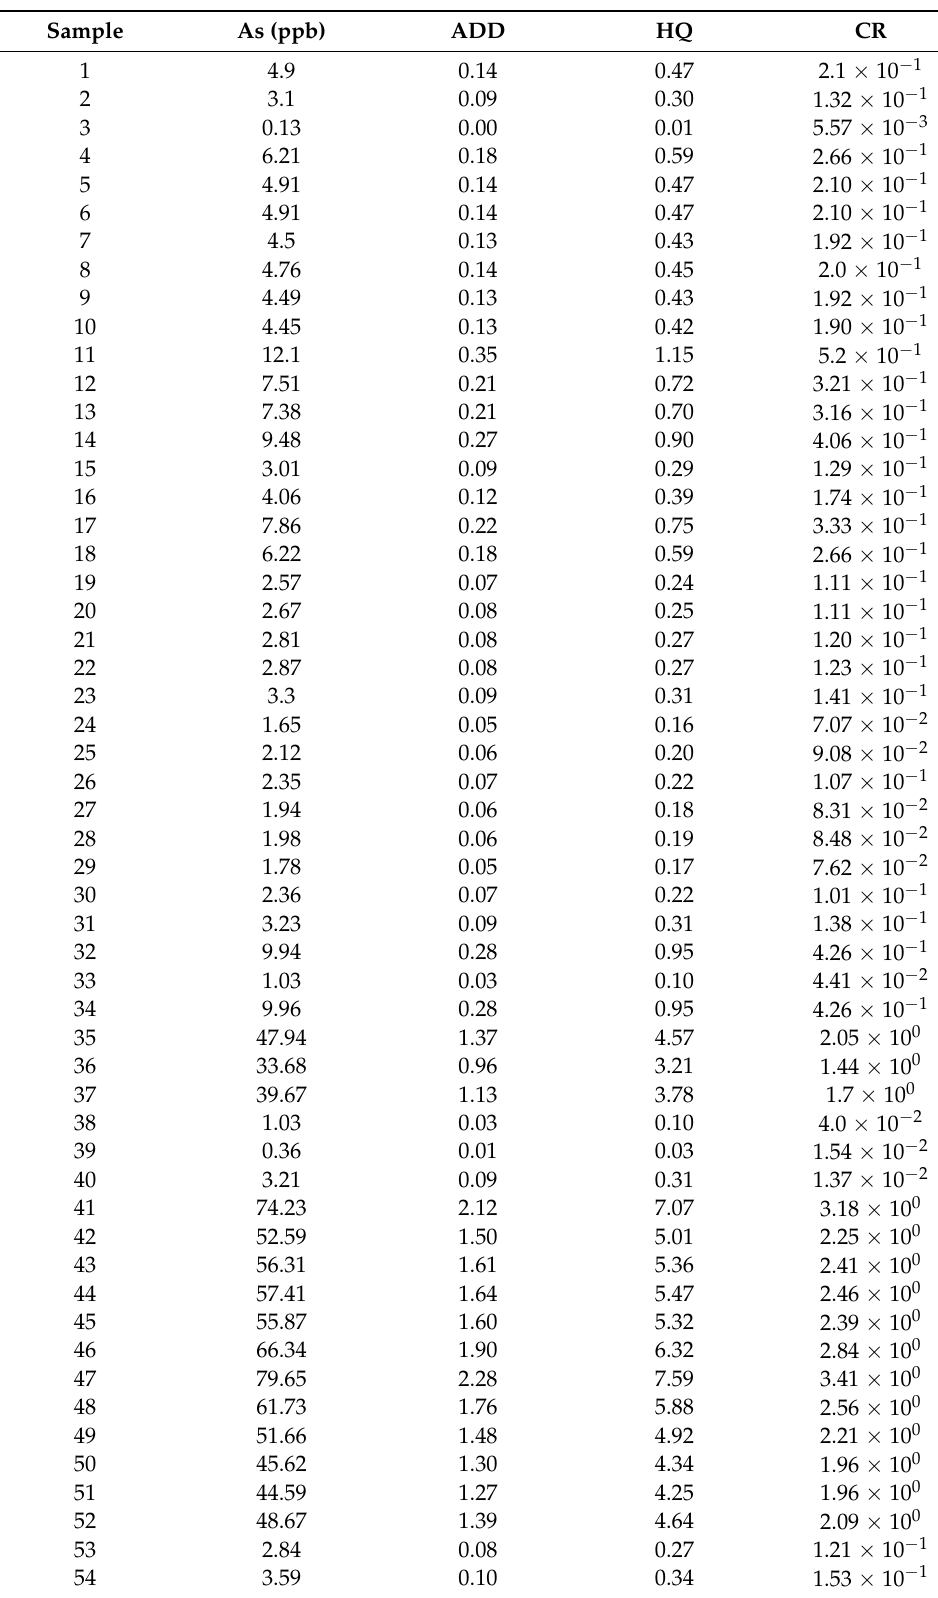
Table 4. Average daily intake (mg/kg/day), hazard quotient, and cancer risk assessment results calculated for the groundwater of the research